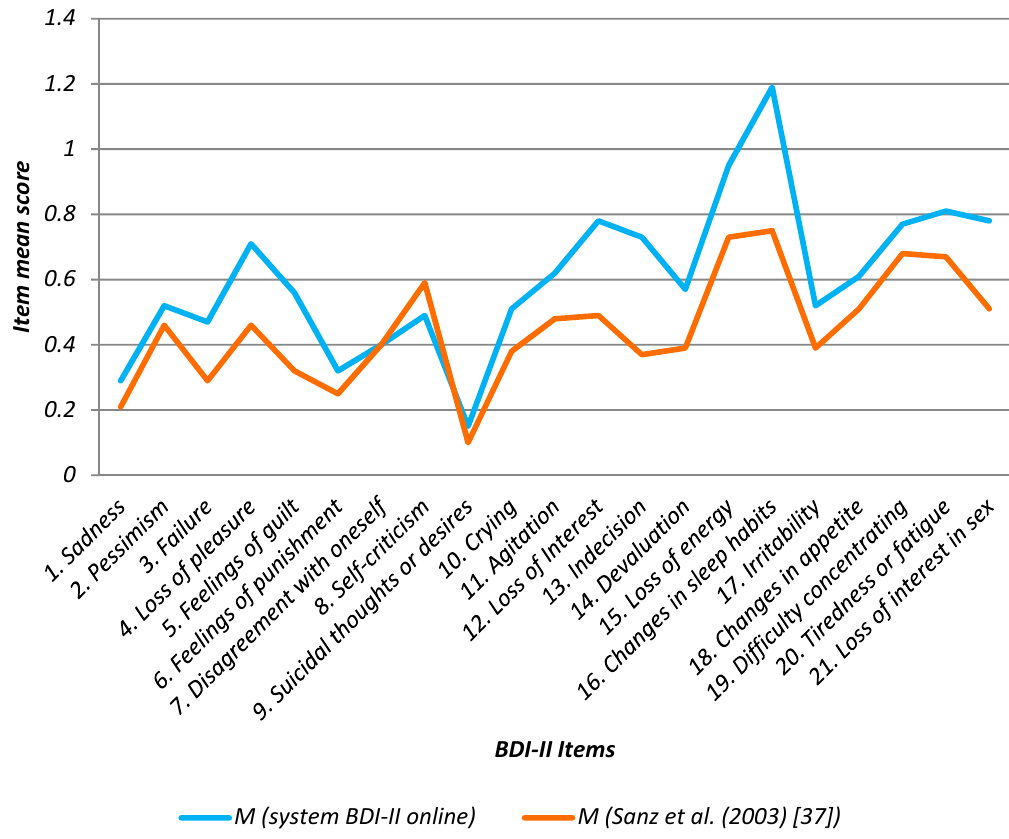
Figure 11. Mean values (M) of 21 BDI-II items in system online BDI-II vs Sanz et al., (2003)